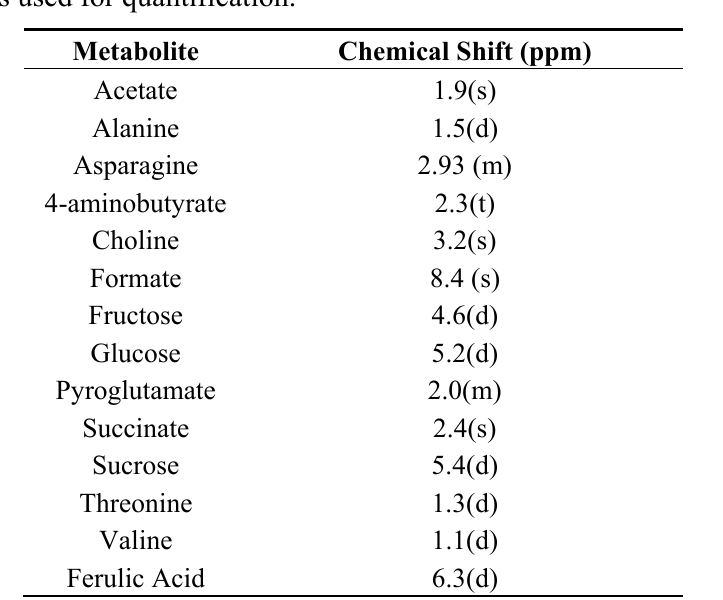
Table 1. Chemical shifts of metabolites identified in 1 H-NMR Spectra of different sources of Angelica roots used for